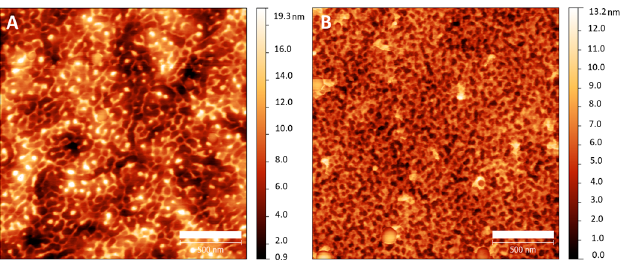
Figure 9. Atom force microscopy (AFM) pictures of block copolymer brush thin films prepared from pure THF ( A ) or THF / water ( B ) solution of sample 1. Scale bars: 500 nm.